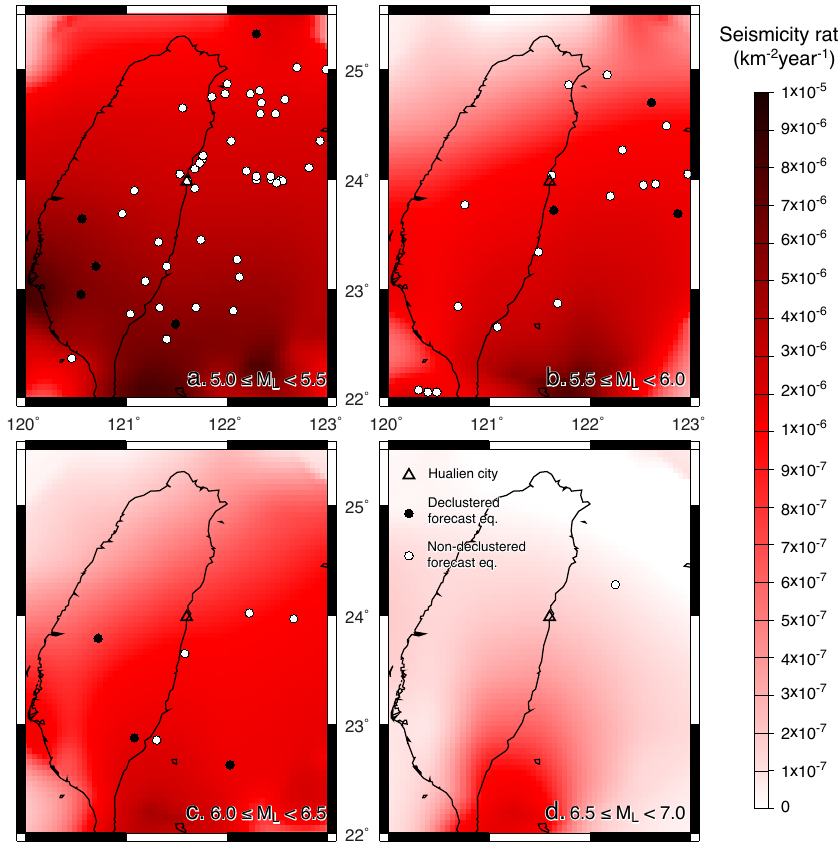
Fig. 4. The distribution of the reference seismicity rate acquired for (a) 5.0 ≤ M L < 5.5, (b) 5.5 ≤ M L < 6.0, (c) 6.0 ≤ M L < 6.5, and (d) 6.5 ≤ M L < 7.0. Declustering (black dots) and non-declustering (white dots) earthquakes occurring during the forecasting period are